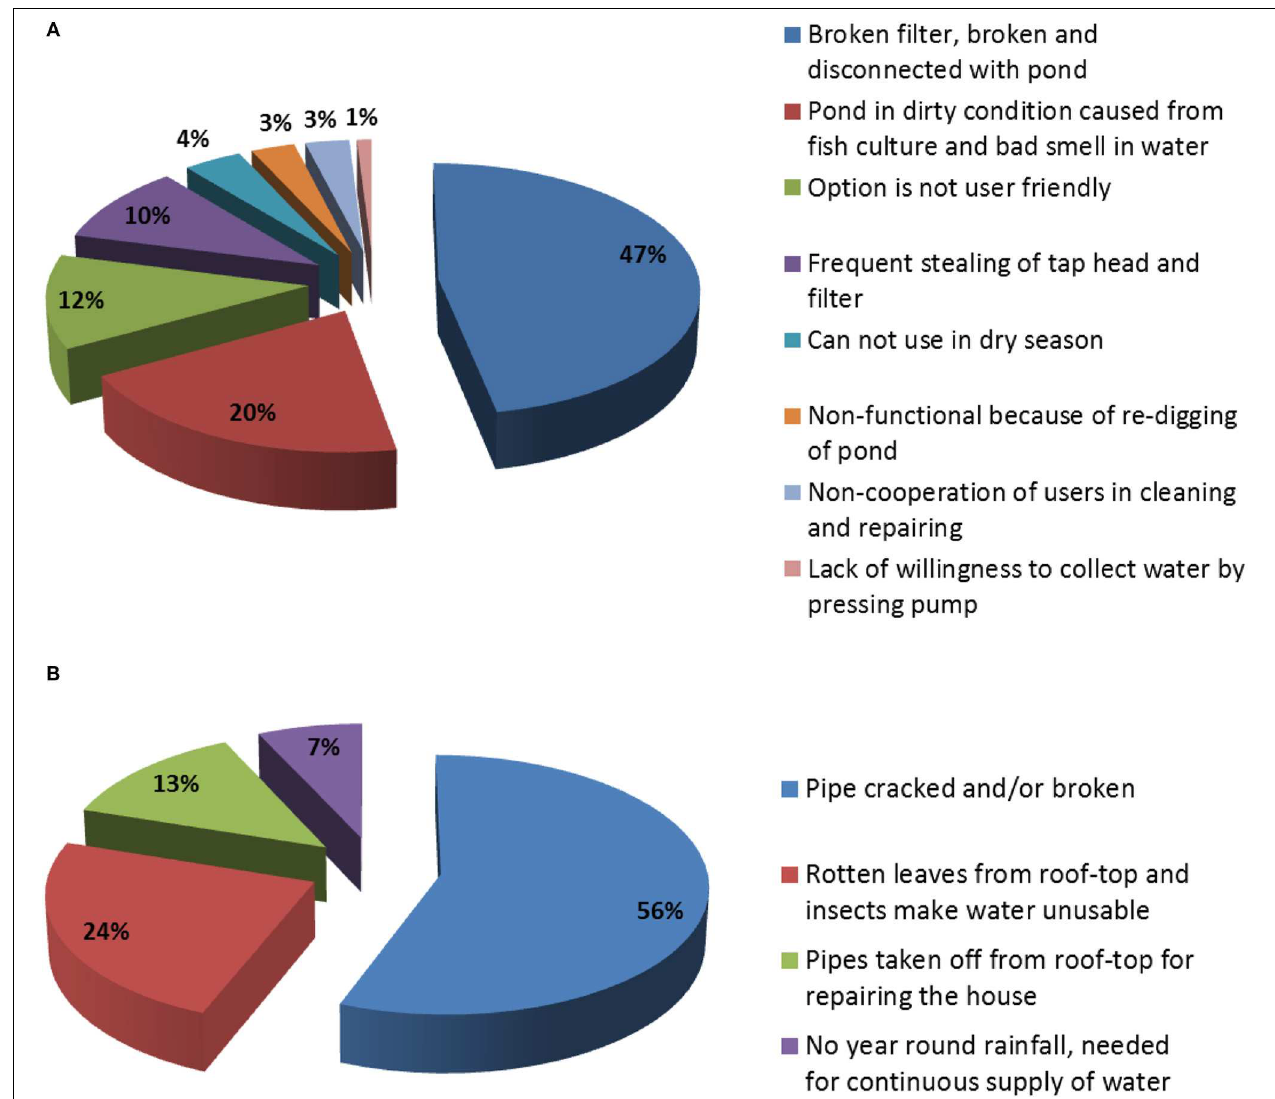
FIGURE 9 | Reasons for switching from (A) PSF and (B) RWH to